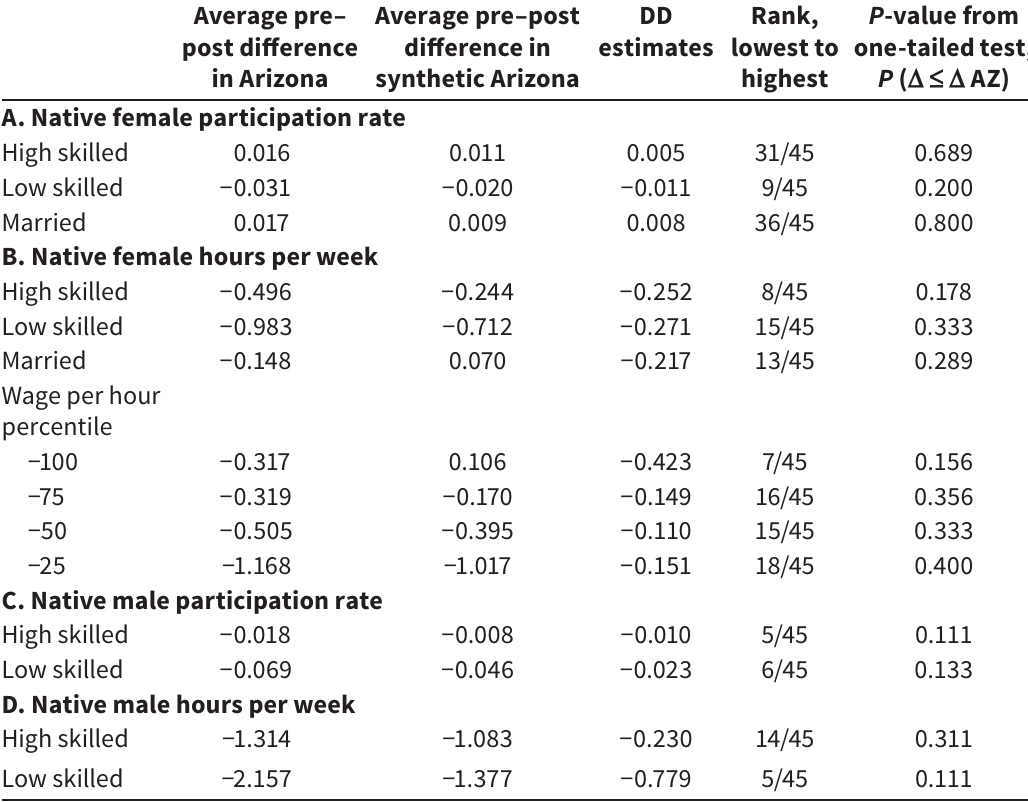
LAWA and native labor